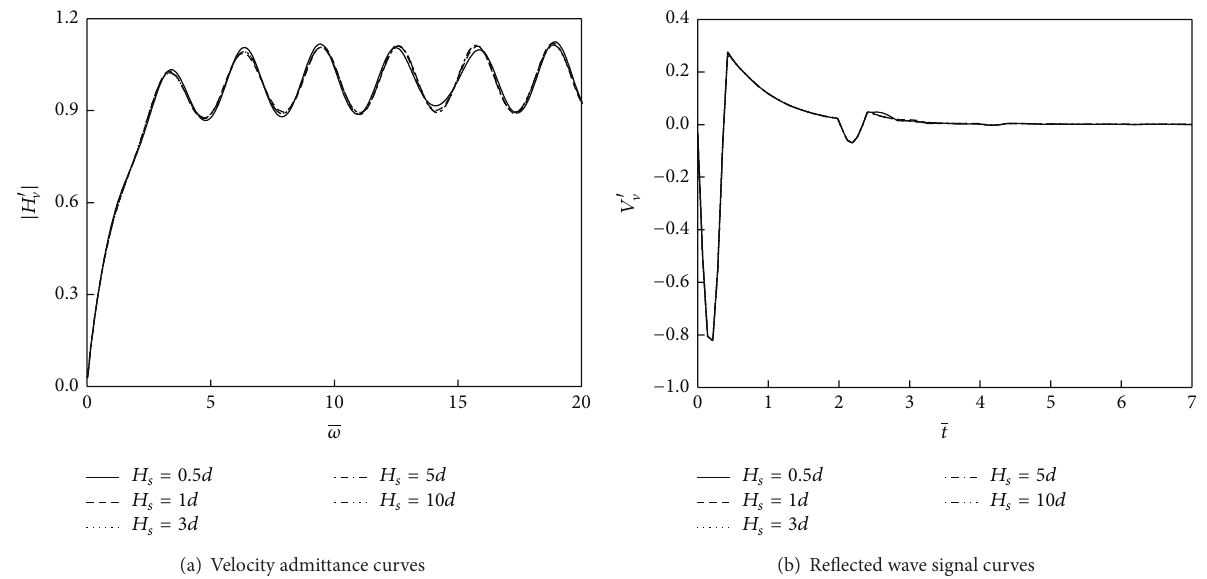
Figure 3: Influence of thickness of pile end soil on the dynamic response at pile head when 𝐻 𝑝 = 20 m.